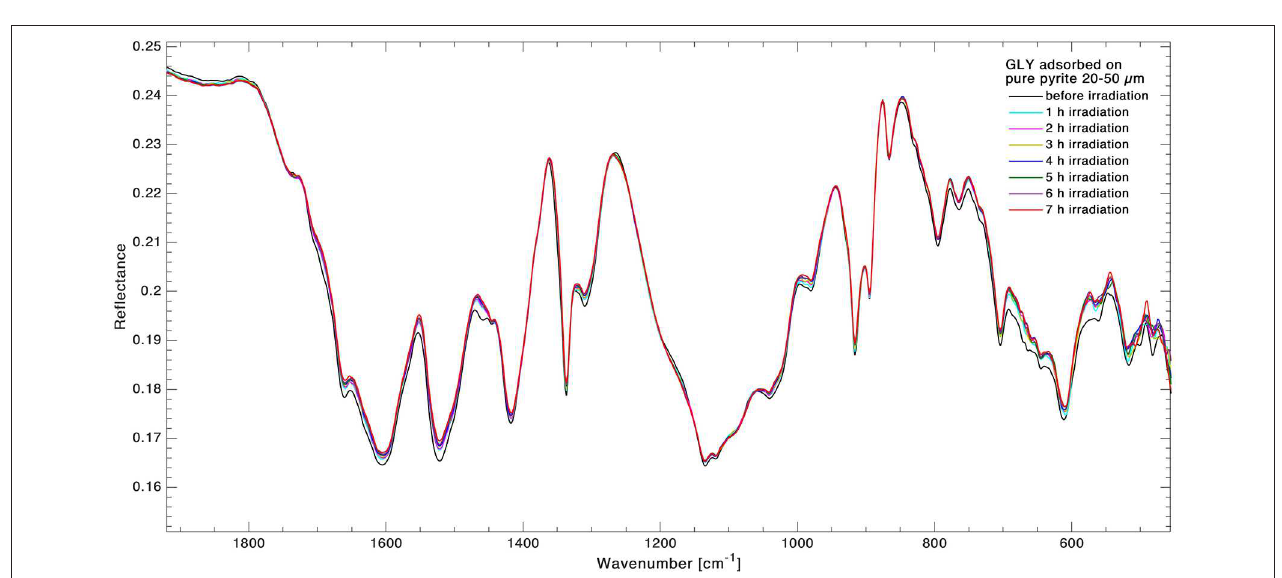
at room temperature. In this case, we collected only the final